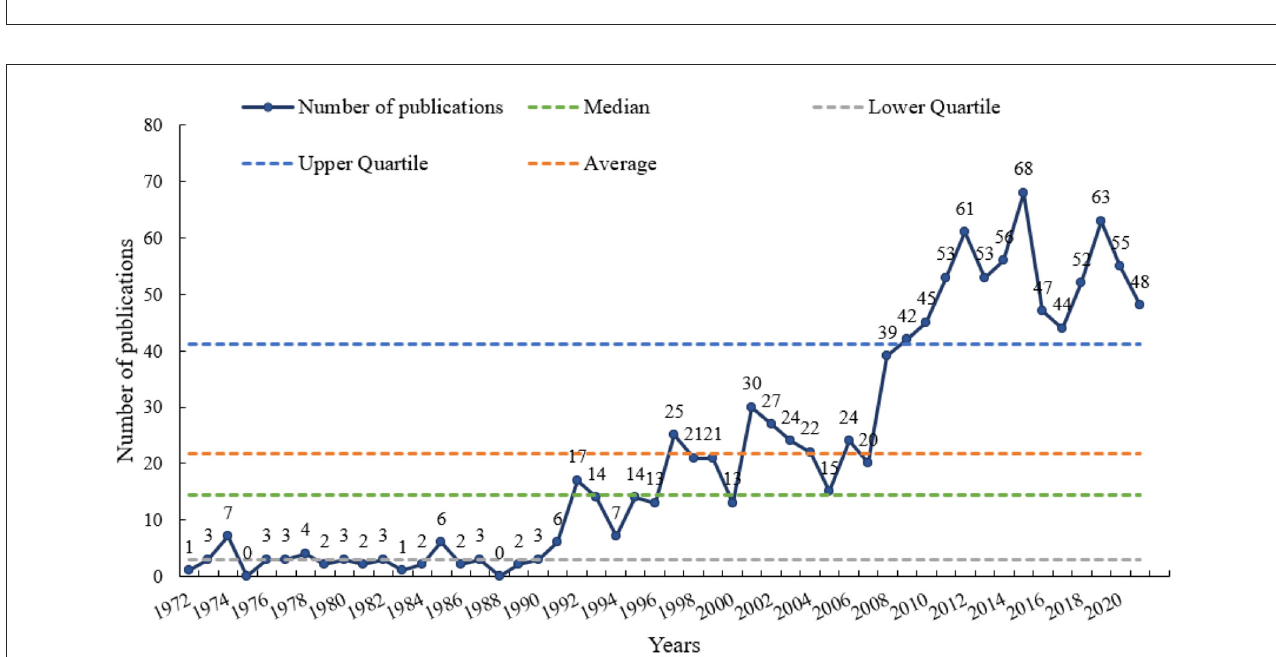
FIGURE1 Flow chart of case selection.